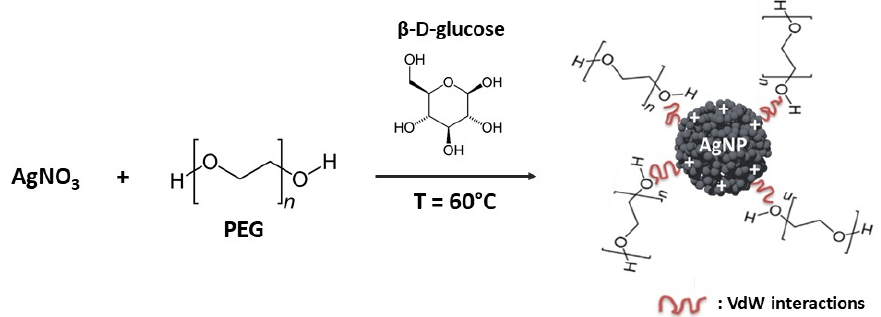
Figure 11. Poly(ethylene) glycol (PEG) coated method of silver nanoparticles. Inspired from [130].